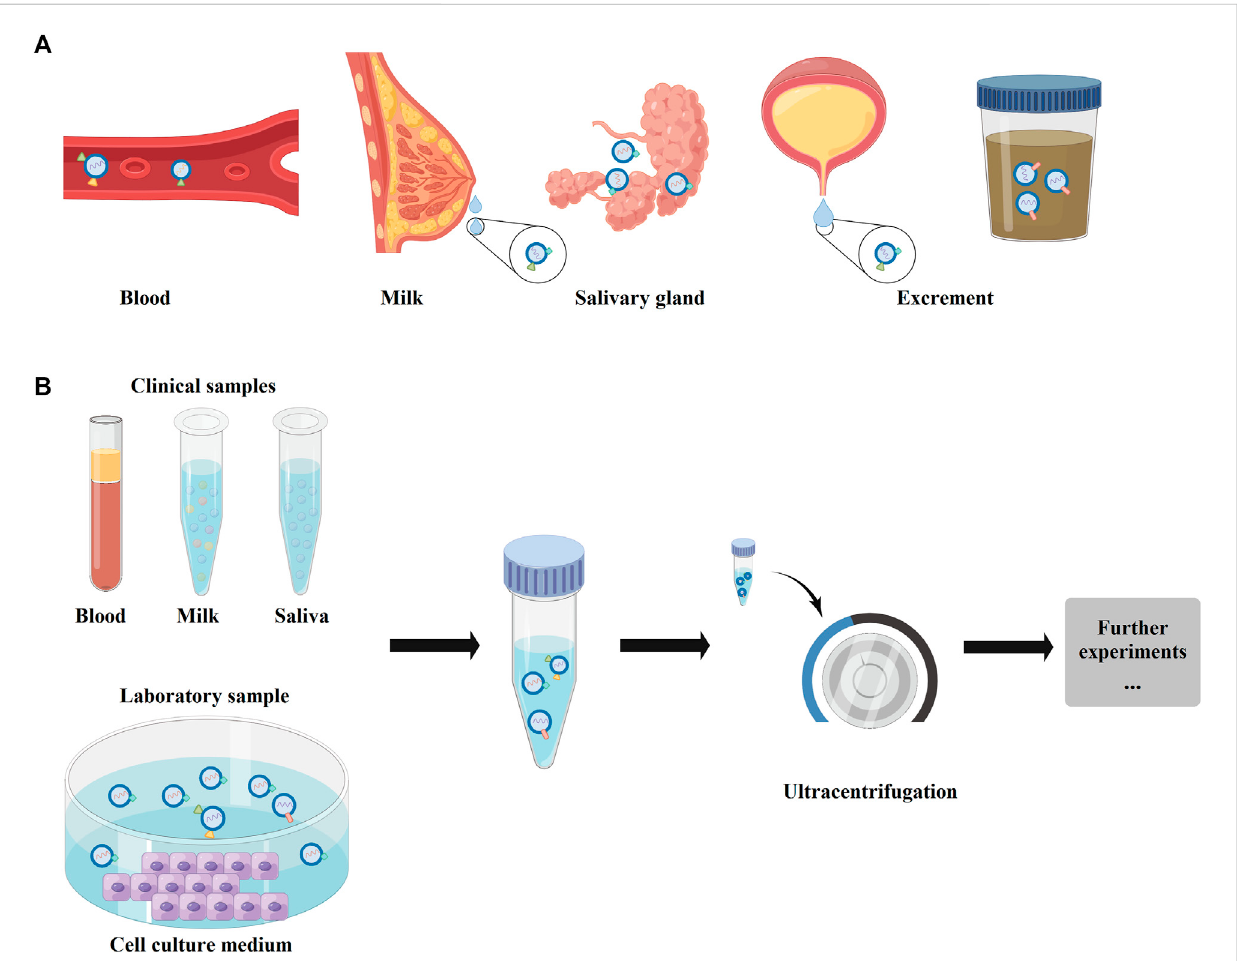
FIGURE 2 The physiological distributions and the main extraction method of exosomes. (A) The physiological distributions of exosomes, which could exist in blood, milk, salivary gland, and excrements (urine or feces). (B) The main extraction method of exosomes. For clinical samples, the exosomes could be collected from blood, milk, or saliva. In laboratory, the exosomes mainly were extracted from cell culture